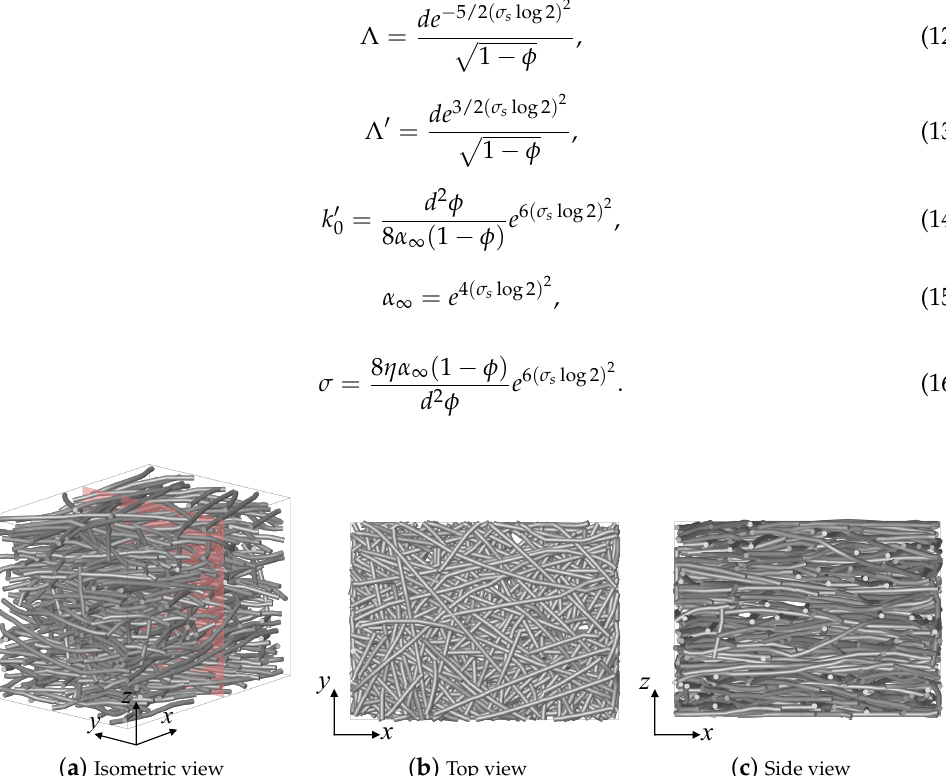
Figure 1. 3D geometrical model of sintered metal fibre materials based on micro-CT image recon- struction. The red square plane in ( a ) denotes a slice of the micro CT scan. ( b ) Top view of the model in x - y plane. ( c ) Right view of the model in x - z